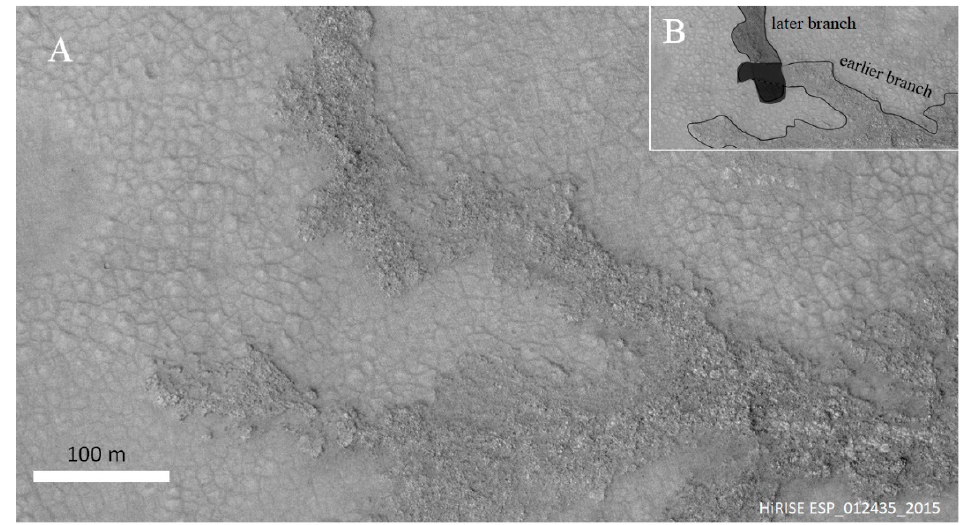
Figure 14. ( A ) Another example of superposing dendritic branches. ( B ) Interpreted order of superposition. The area shown here is marked with a rectangle in Figure 10.